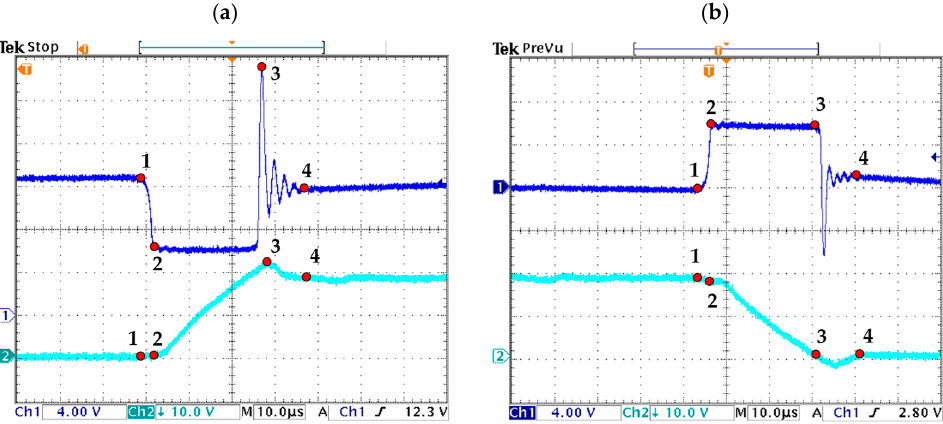
Figure 17. Voltage (blue) and current (cyan) transients; ( a ) refers to the mark 1 and ( b ) to the mark 2 in Figure 16. The time base is 10 µs. in Figure 16. The time base is 10 µ